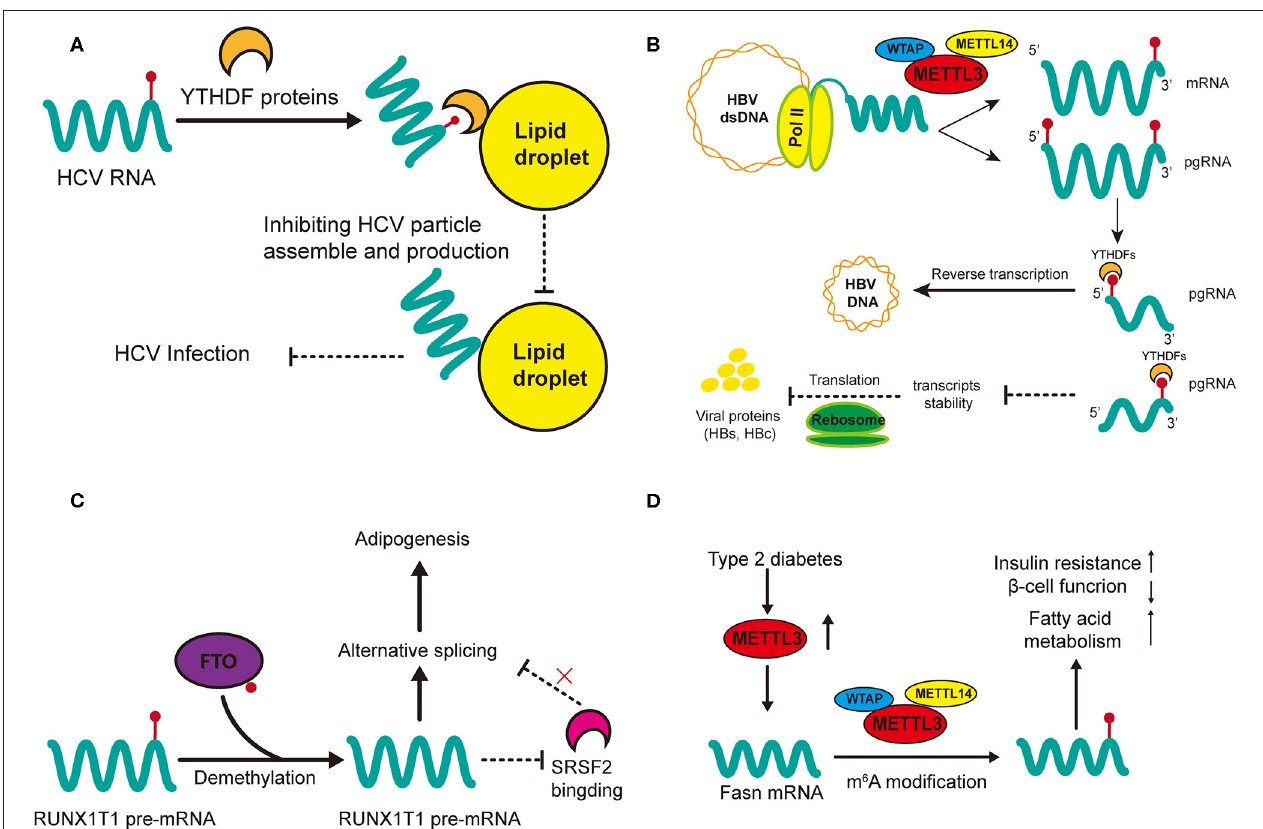
FIGURE 3 | Regulatory functions of m 6 A in HCC-related hepatic diseases. m 6 A regulation in HCV (A) and HBV (B) affect viral activities (infection and replication) while m 6 A modification in non-alcohol fatty liver disease (NAFLD) promotes adipogenesis (C) and insulin resistance (D) . (A) m 6 A-modified HCV RNAs are recruited by YTHDF proteins onto lipid droplets to impede the assembly of unmodified RNAs, thus inhibiting the production of HCV infectious particles. (B) m 6 A modification at the 5 ′ terminus of the pregenomic RNA (pgRNA) is required for HBV reverse transcription while m 6 A at the 3 ′ terminus of pgRNA lead to destabilization of HBV transcripts. (C) FTO promotes the demethylation of RUNX1T1 pre-mRNA; this inhibits SRSF2 binding and alters the alternative splicing of pre-mRNA, therefore promoting adipogenesis. (D) The expression of METTL3 is upregulated in type 2 diabetes. Upregulated METTL3 inhibits hepatic insulin sensitivity through m 6 A modification of Fasn mRNA and facilitates fatty acid